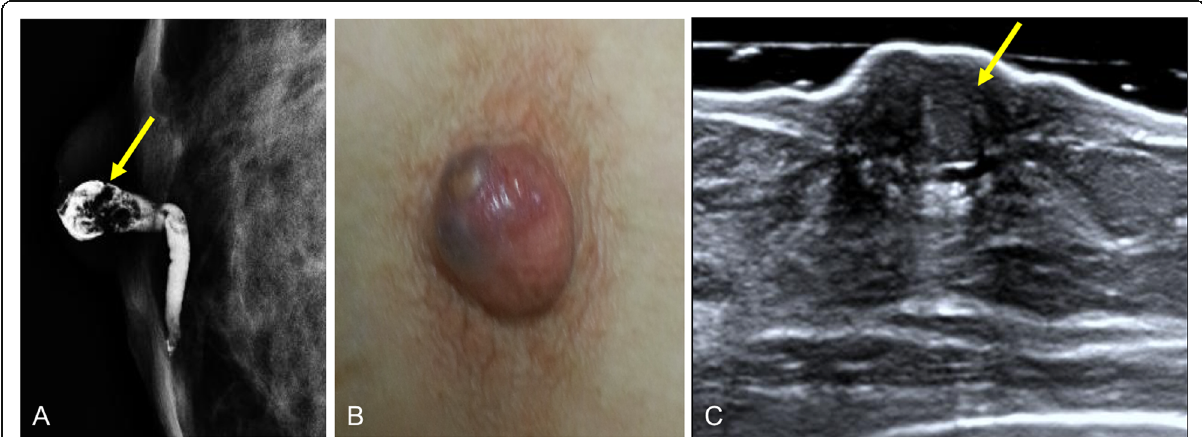
Fig. 25 Intraductal filling defect. A 48-year-old woman with bloody discharge from a single orifice in the right breast and negative findings at mammography and ultrasound (images not shown). a Craniocaudal ductogram shows a filling defect just behind the secreting orifice (arrow). Histologic study: solitary intraductal papilloma. b Photograph of a bluish nodule that appeared in the same breast five years later; c ultrasound shows the lesion as a solid nodule (arrow). Histologic study: solitary intraductal papilloma (inverted)